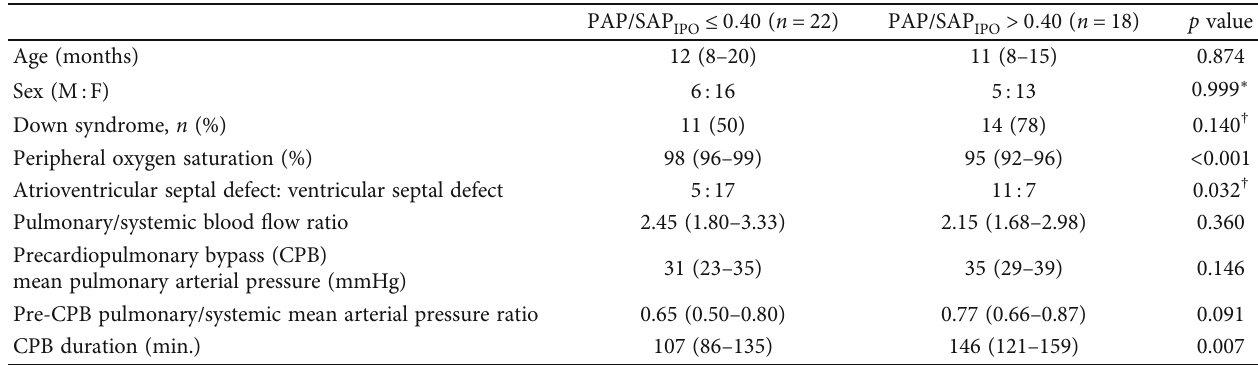
Table 2: Preoperative and intraoperative data in hemodynamic groups.